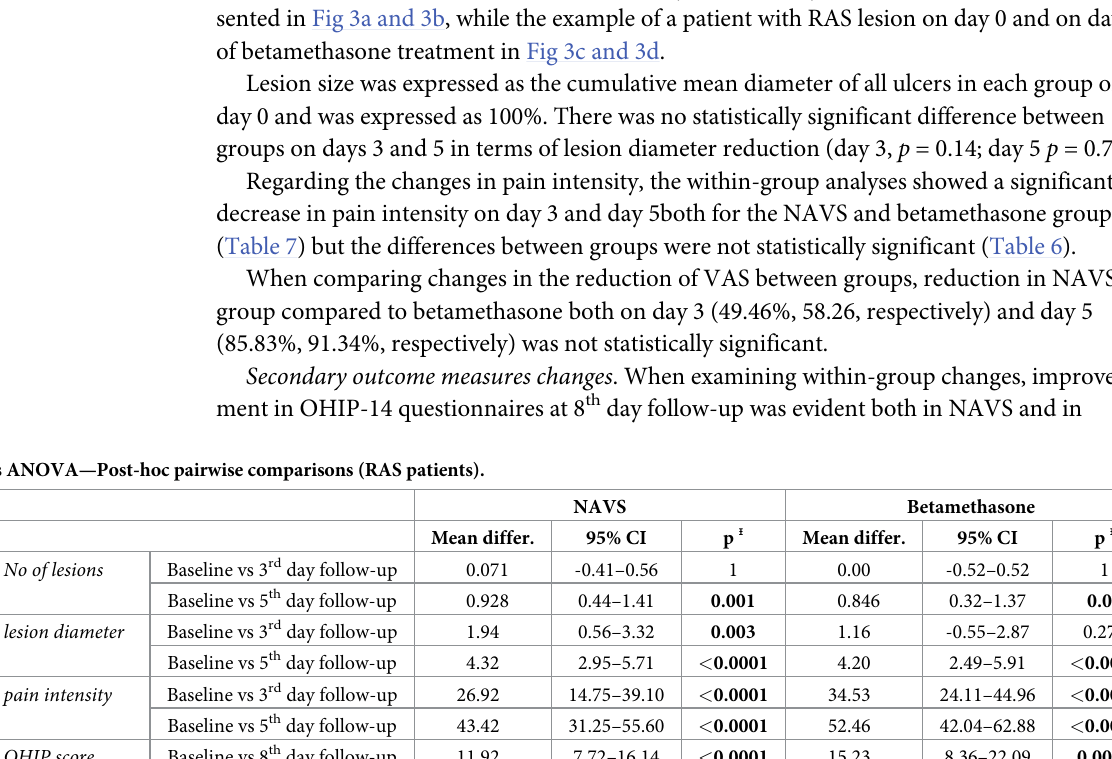
NAVS Betamethasone Mean differ. 95% CI p ᵻ Mean differ. 95% CI p